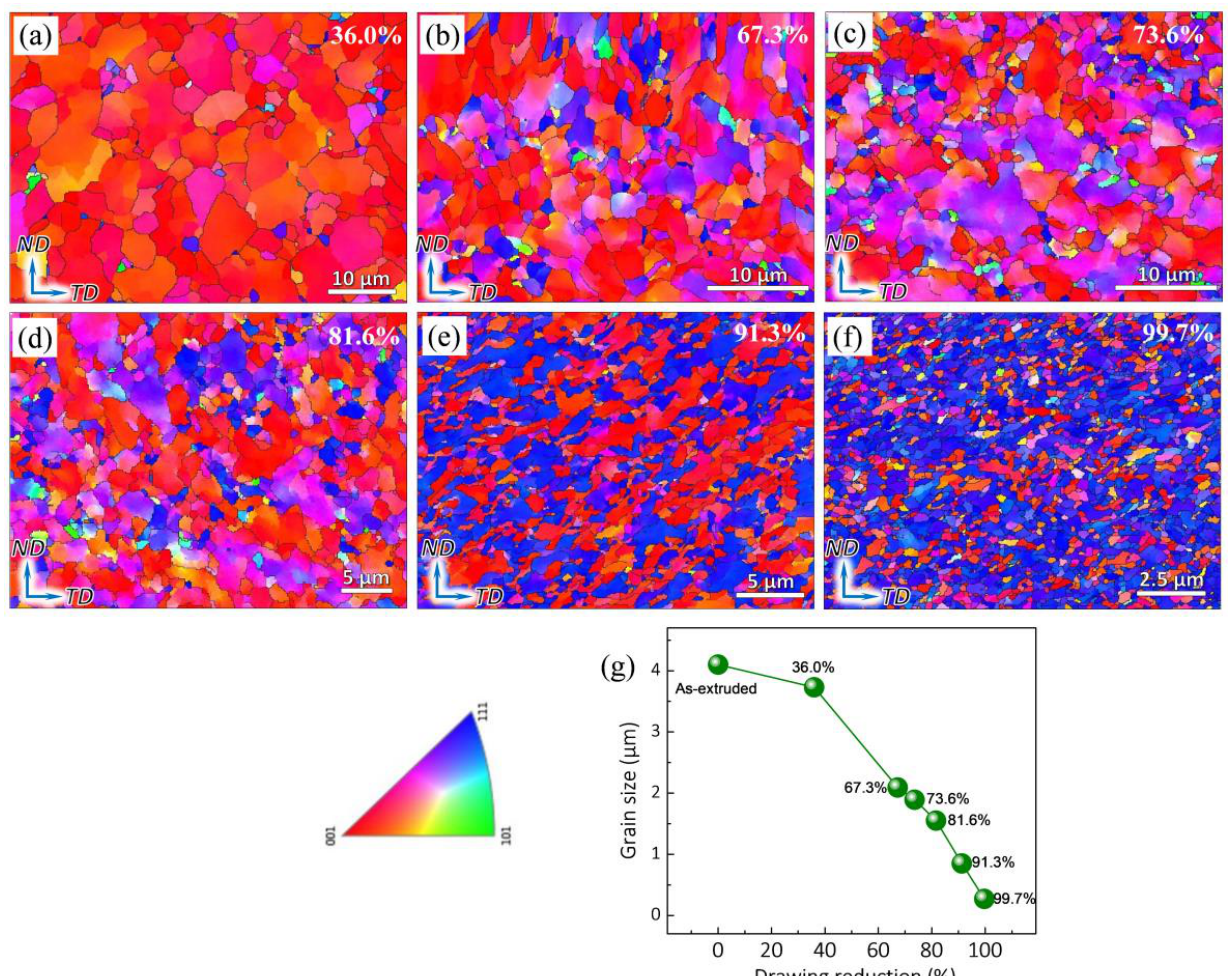
Figure 6. IPF images of the as-drawn composites with different drawing reductions. ( a ) 36.0%, ( b ) 67.3%, ( c ) 73.6%, ( d ) 81.6%, ( e ) 91.3%, and ( f ) 99.7%. ( g ) The variation of grain size with different drawing reductions.